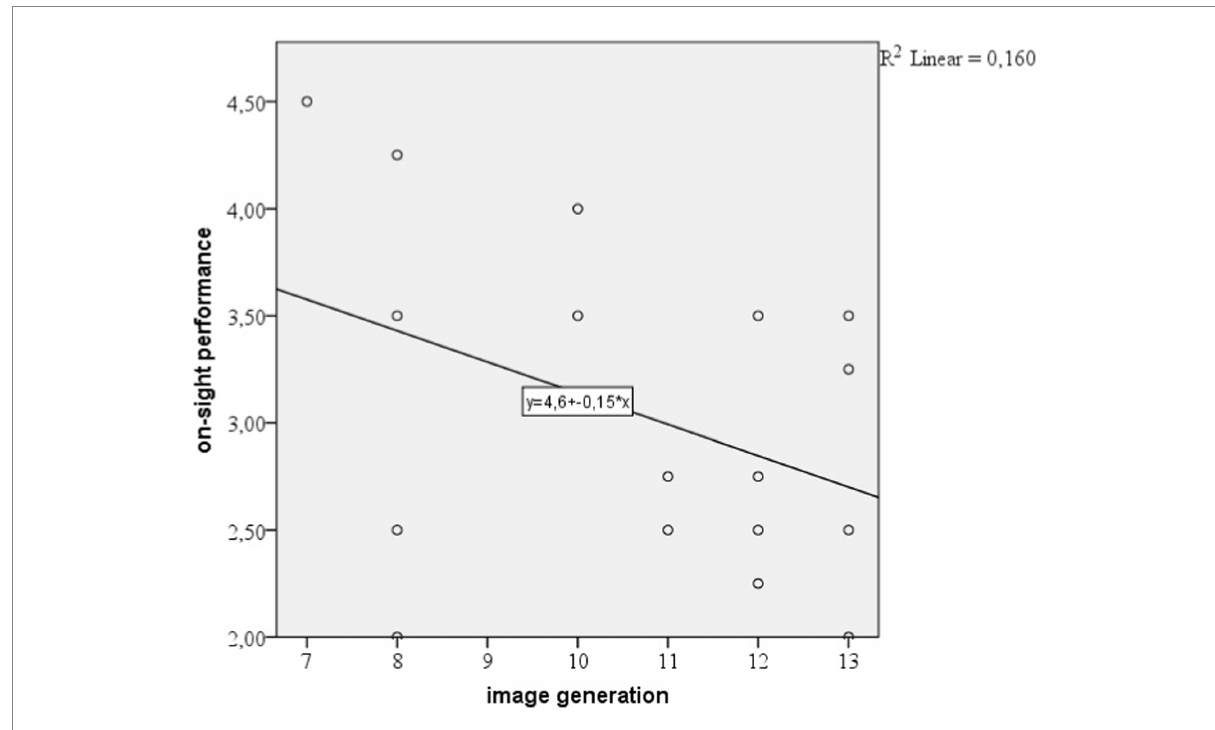
FIGURE 4 Scatterplot explaining simple linear regression between image generation and on sight performance.